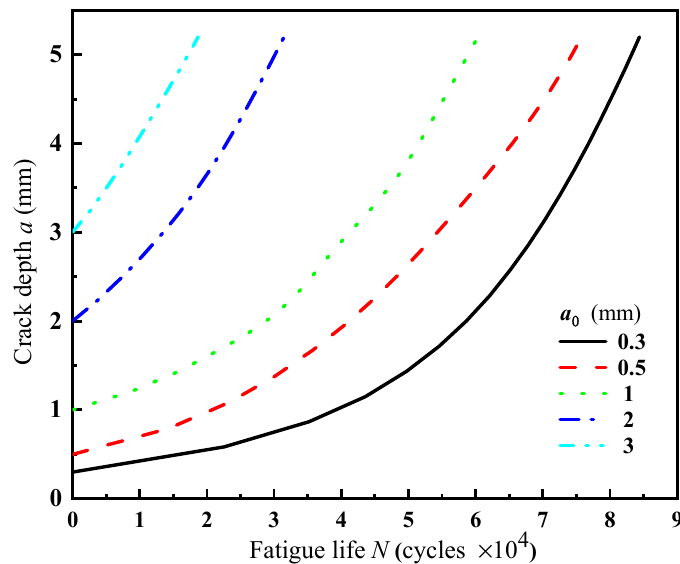
Figure 12. The a-N curve of initial crack growth with different sizes.